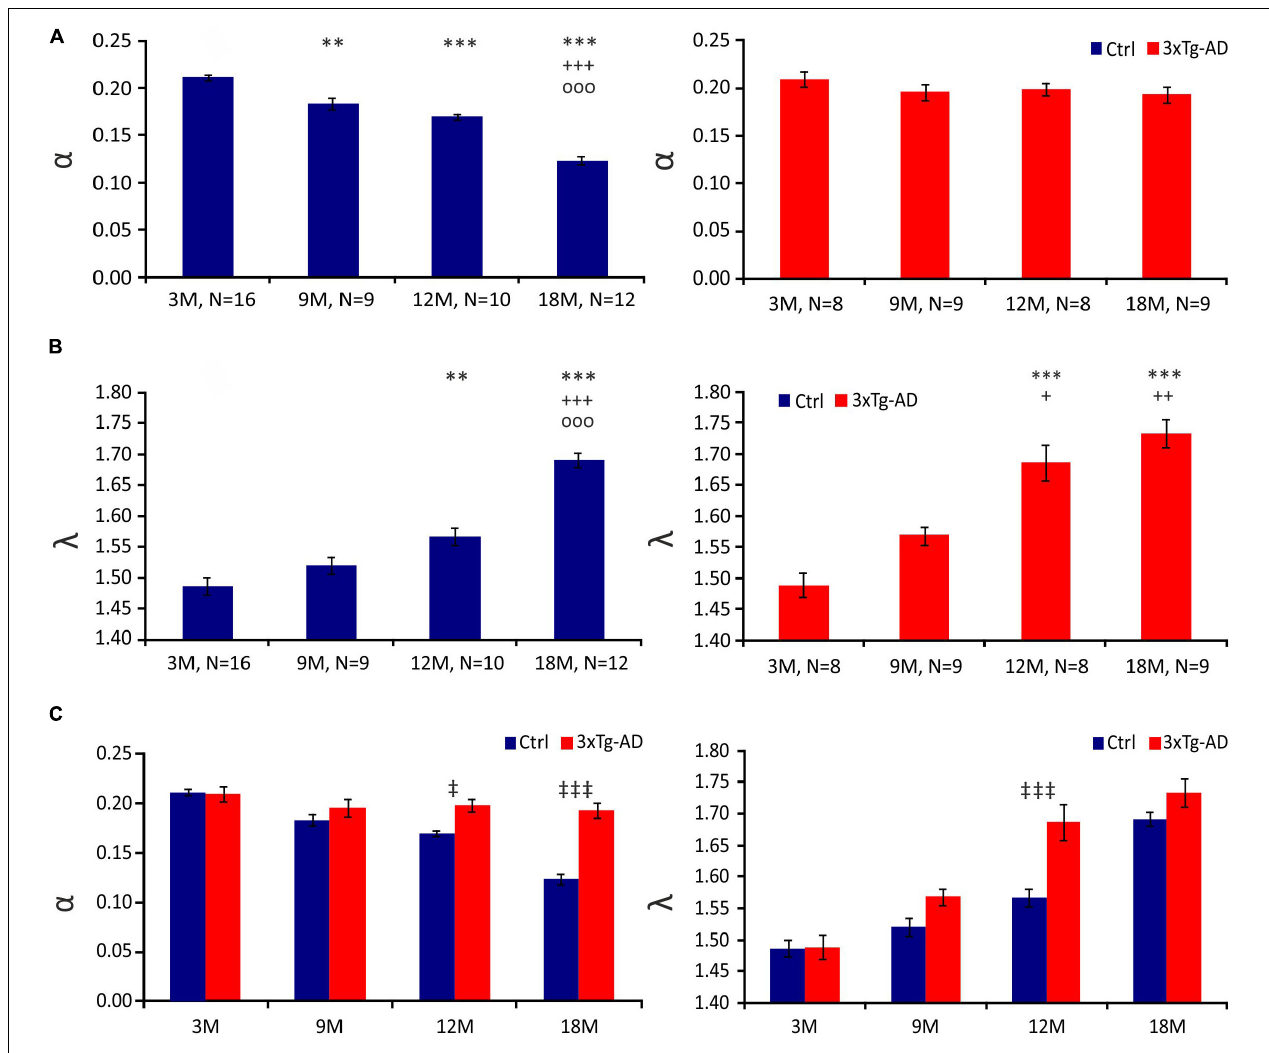
FIGURE 2 | Diffusion parameters of extracellular space during aging of control (Ctrl) and 3xTg-AD mice at 3, 9, 12 and 18 months (3, 9, 12 and 18M). Average values of the volume fraction α (A) and tortuosity λ (B) during aging in Ctrl (left) and 3xTg-AD mice (right). Note the continuous decrease in α during a physiological aging which is missing in 3xTg mice. A marked increase in λ occurred in 3xTg-AD animals earlier than in Ctrl mice. Comparison of values of α (left) and λ (right) between Ctrl and age-matched 3xTg-AD mice (C) . Data are expressed as mean ± SEM. Statistical significance was determined by Student’s t -test with Benjamini-Hochberg post-hoc test. Asterisks, crosses, circles and double daggers indicate significant differences ( p < 0.05 [ ∗ /+/o/ ‡ significant]; p < 0.01[ ∗∗ /++/oo/ ‡‡ very significant]; p < 0.001 [ ∗∗∗ /+++/ooo/ ‡‡‡ extremely significant]). * indicates a significant difference related to the values of 3M-old mice; + indicates a significant difference related to the values of 9M-old mice; o indicates a significant difference related to the values of 12M-old mice, ‡ indicates a significant difference between Ctrl and age-matched 3xTg-AD mice. Ctrl, control mice; 3xTg-AD, triple transgenic model of AD; 3M, 9M, 12M, 18M, 3-, 9-, 12-, 18-month-old animals; N, number of